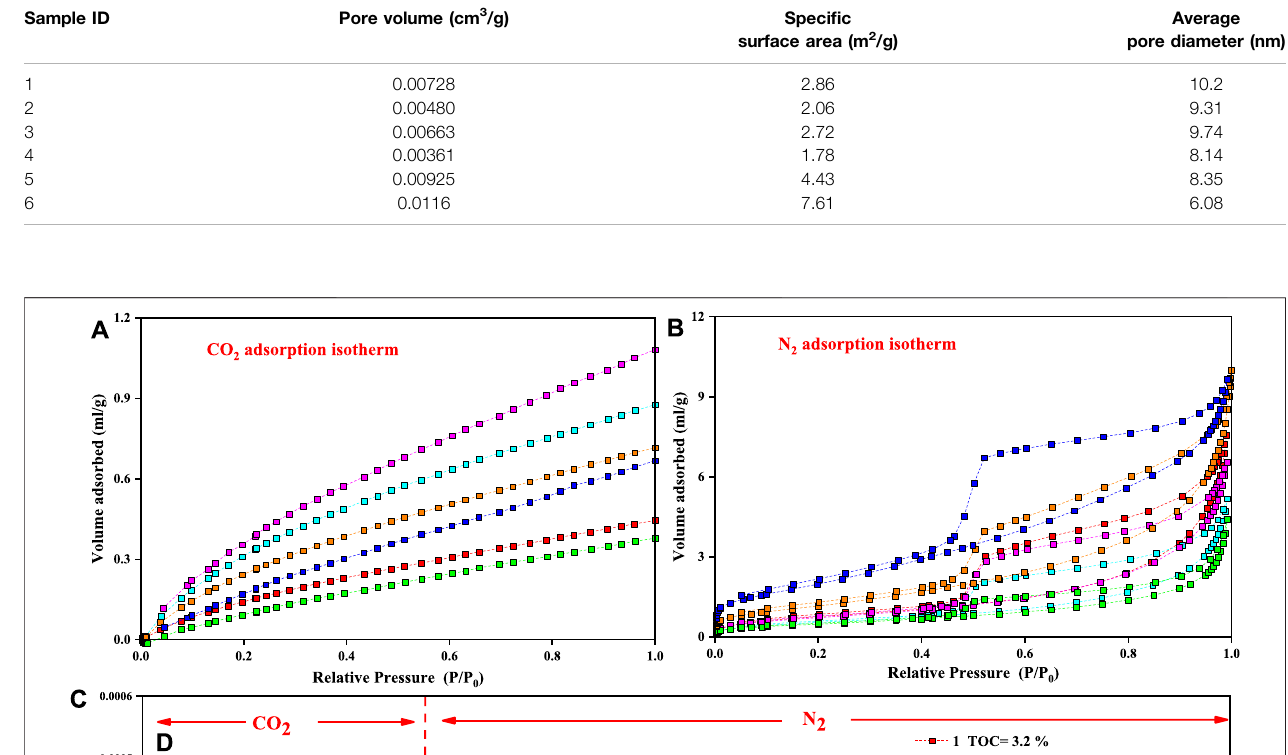
TABLE 3 | Low pressure N 2 -GP results for Shahejie